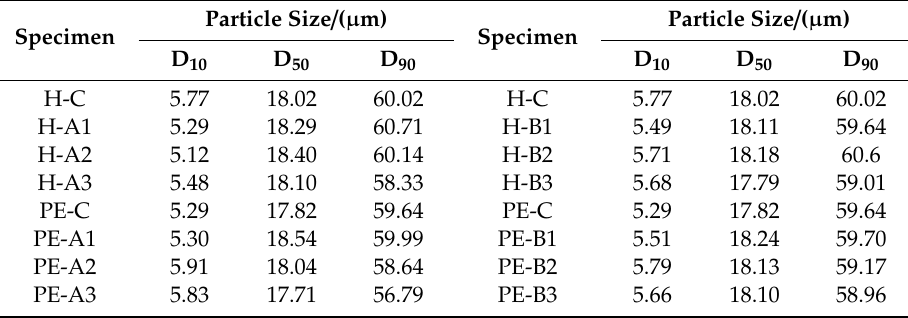
Figure 1. Schematic diagram of the manufacturing process of powder coating. Table 4. Particle size of powder paints.